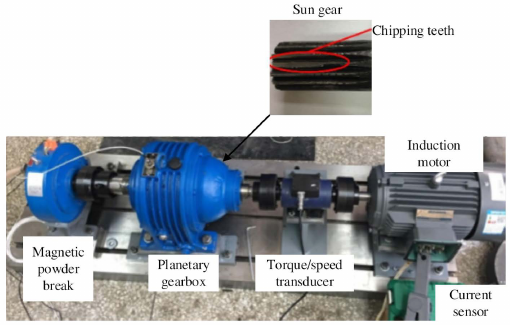
Figure 14. Gearbox test rig and the sun gear